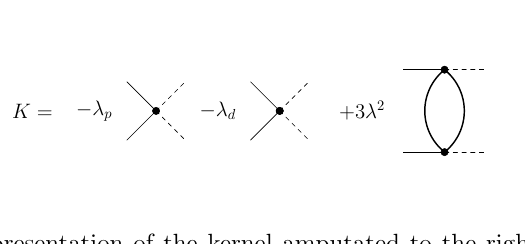
Figure 3 . Graphical representation of the kernel amputated to the right at leading order in N . The (cid:12)rst two terms are based respectively on pillow and double-trace vertices while the last one is based on a pair of tetrahedral